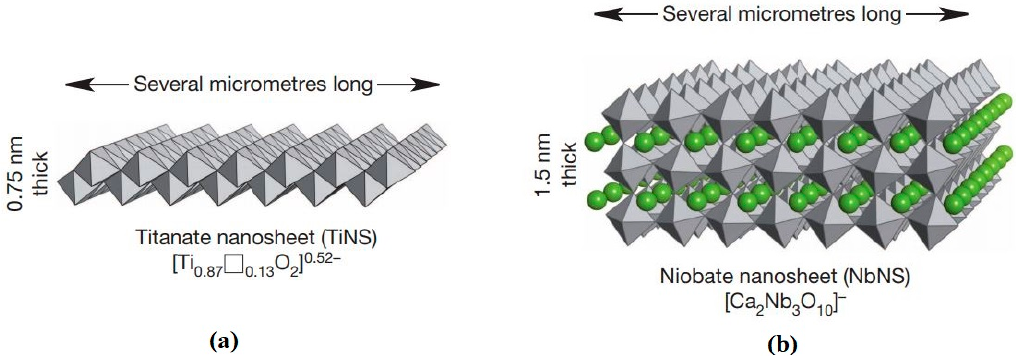
Figure 6. Schematic figure of negatively charged ( a ) unilamellar metal oxide nanosheets of titanate (TiNS) and ( b ) niobate (NbNS) [80]. The cofacially oriented charged nanosheets embedded in hydrogels made the material deform easily when exposed to shear forces while being resilient to compressive forces in the vertical direction. Reproduced from [80] with permission from Nature Publishing Group, 2018.